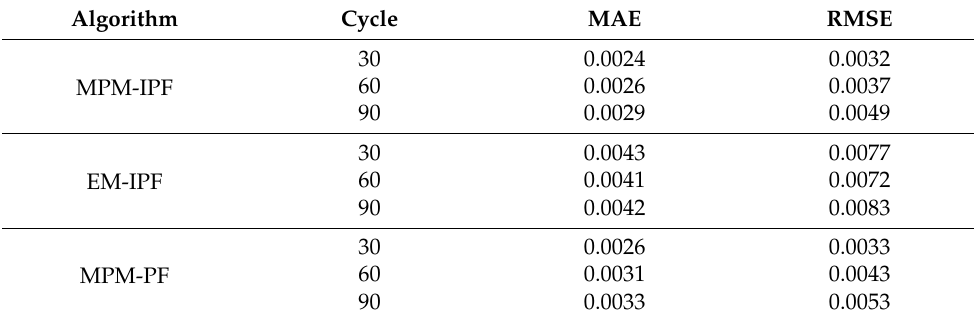
Figure 10. Comparison chart of prediction error of No. 5 battery capacity: ( a ) MAE; ( b ) RMSE. Table 2. Comparison of error results of three algorithms based on No. 5 battery data.